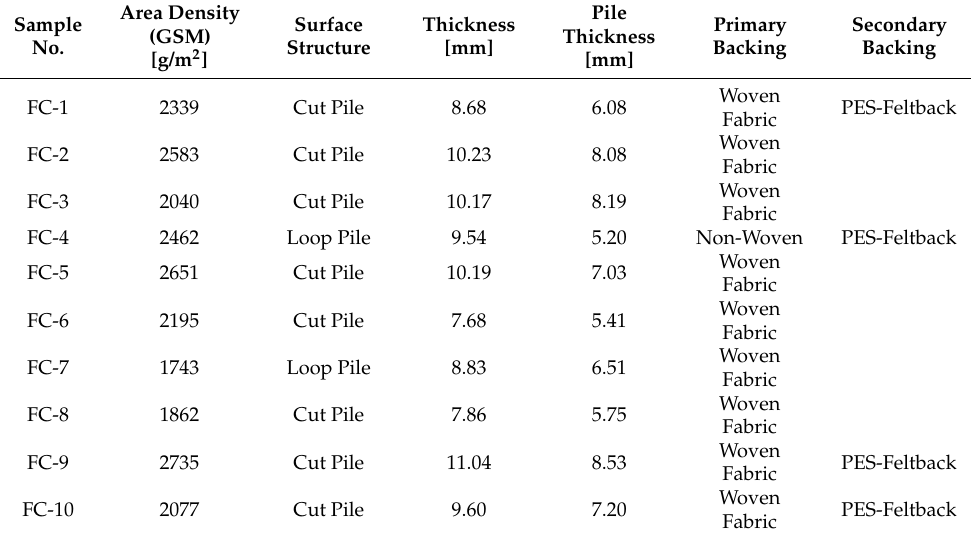
Table 1. Basic information about the different floor covering samples, area density (GSM) gram per square